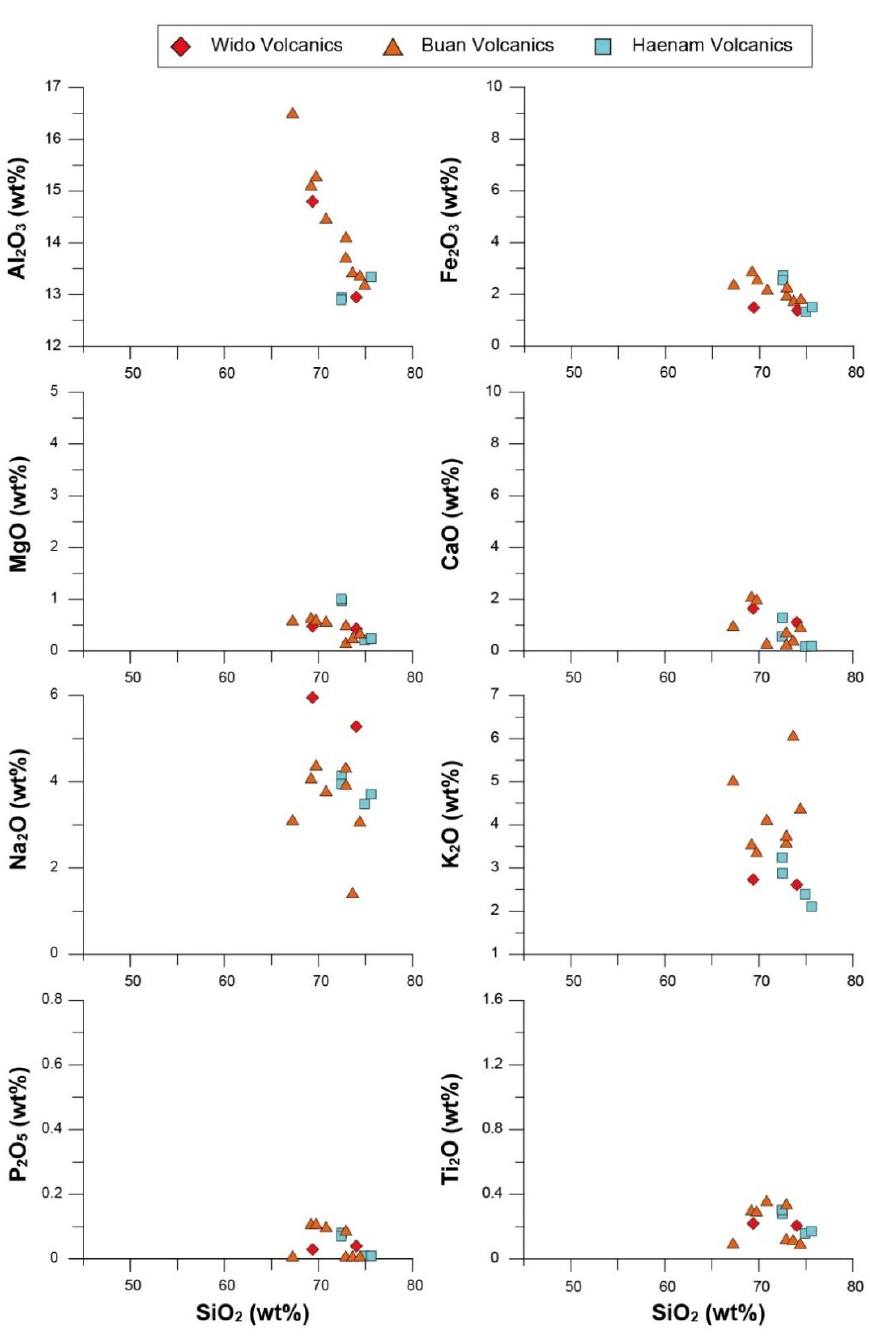
Figure 8. Plots of major elements vs. SiO 2 for the Cretaceous volcanic rocks from the southwestern Korean Peninsula.